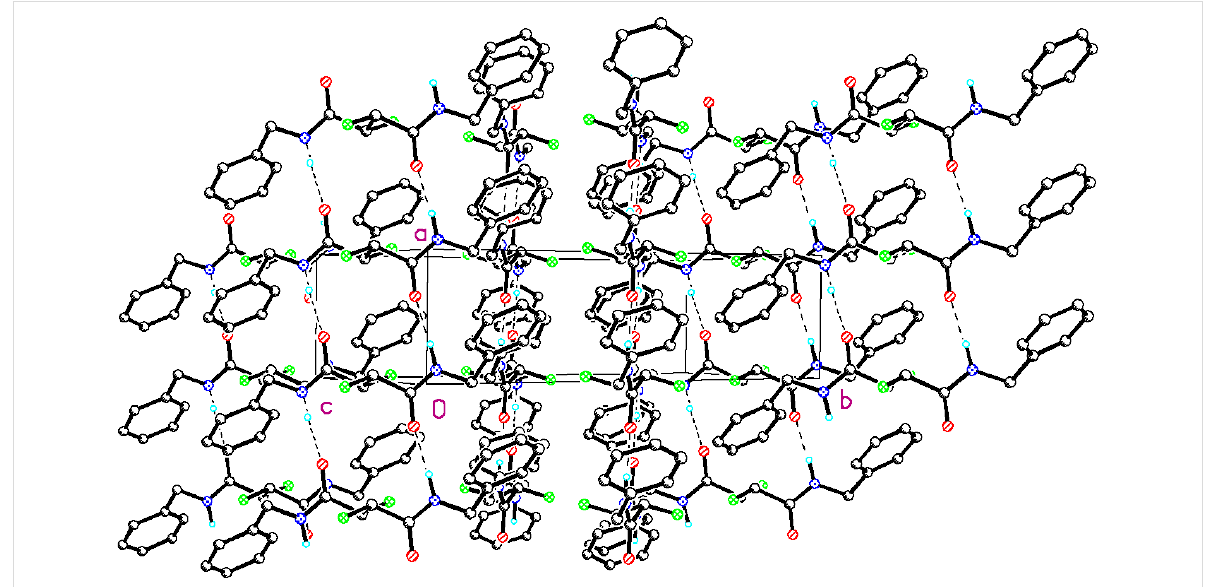
Figure 12: Crystal packing of erythro - 22 clearly indicating intermolecular hydrogen bonding.